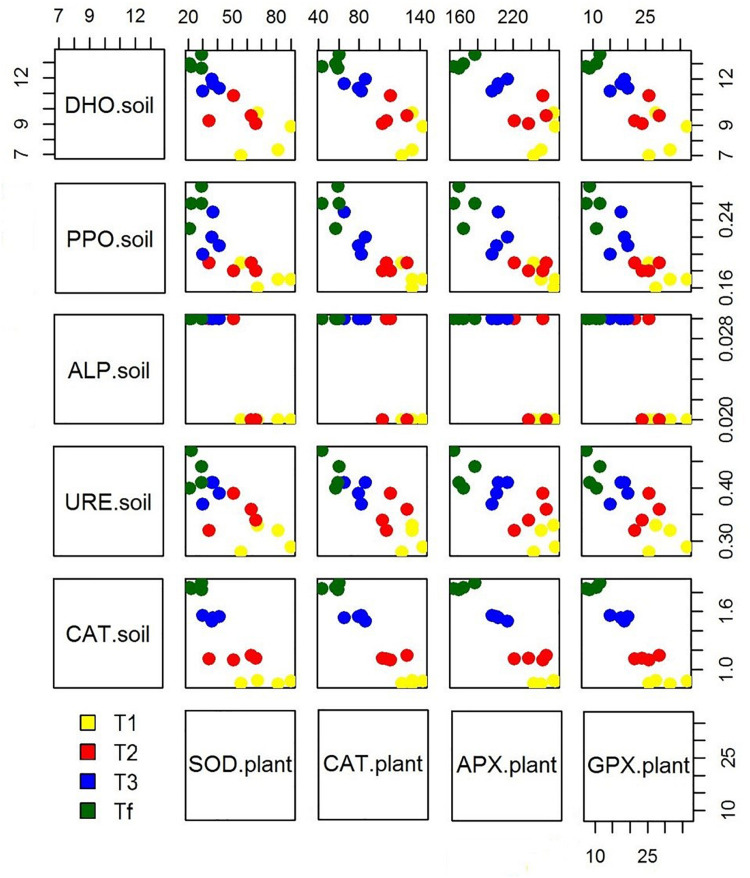
Scatterplot matrix showing the relationship between the soil enzymatic activity and plant stress markers over experimental trial time [0 days (T0), 90 days (T1), 150 days (T2), 210 days (T3), and 270 days (Tf)].